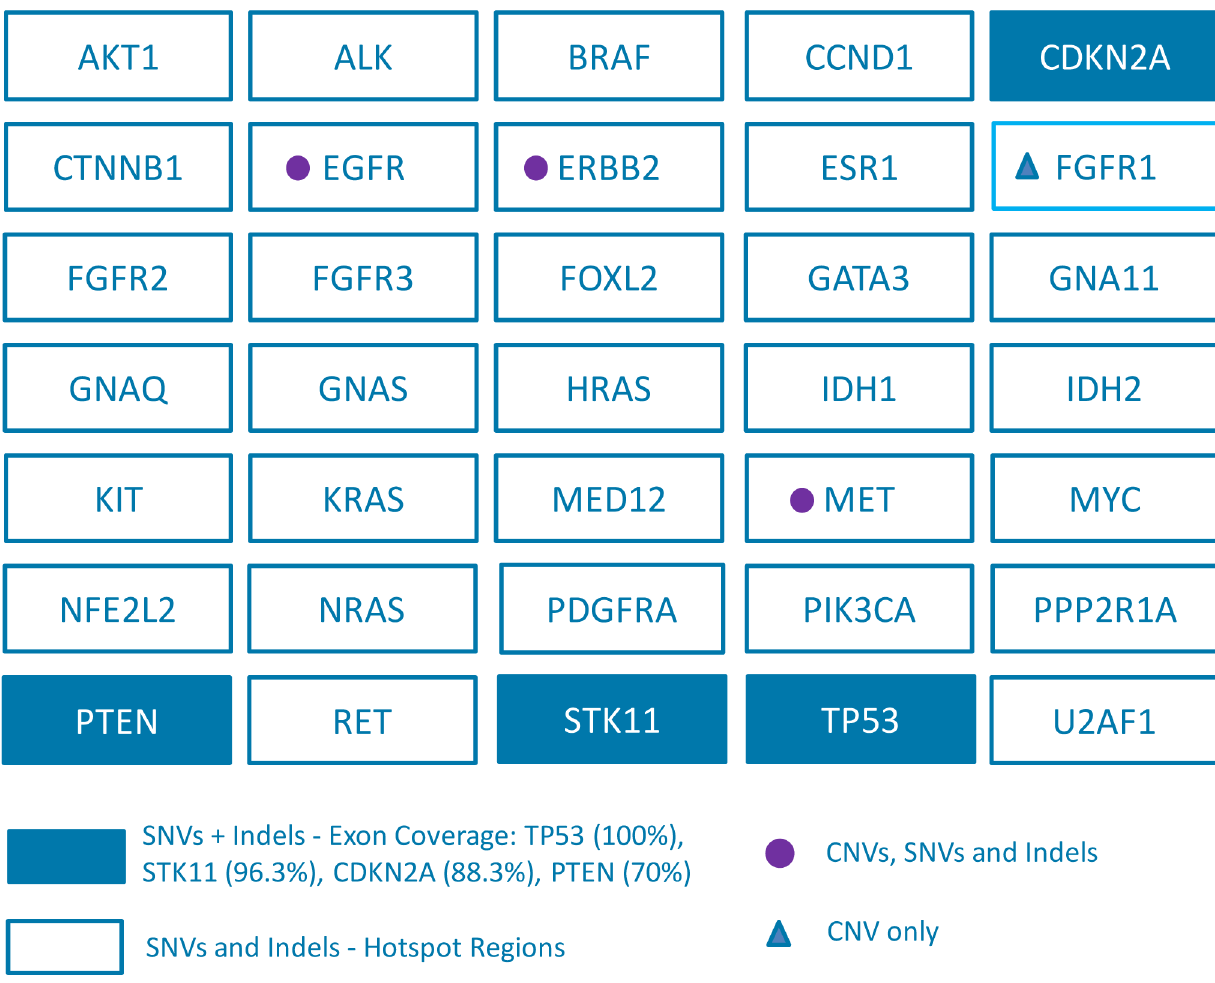
Fig 1. InVision liquid biopsy tumor profiling panel. The coverage per gene is indicated, including hotspots, comprehensive or full coverage of coding regions (70%–100% tiling coverage) and CNVs. SNVs = Single Nucleotide Variants; Indels = short insertions or deletions; CNVs = Copy Number